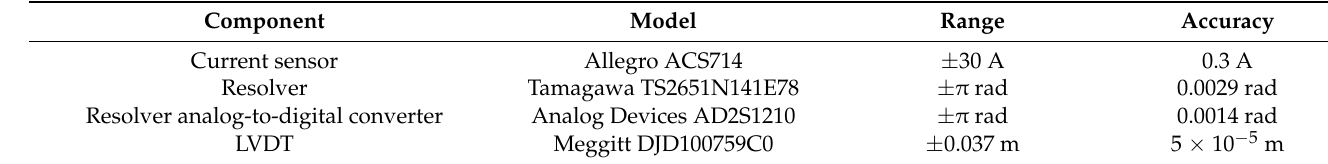
Table 2. EMA control sensors data